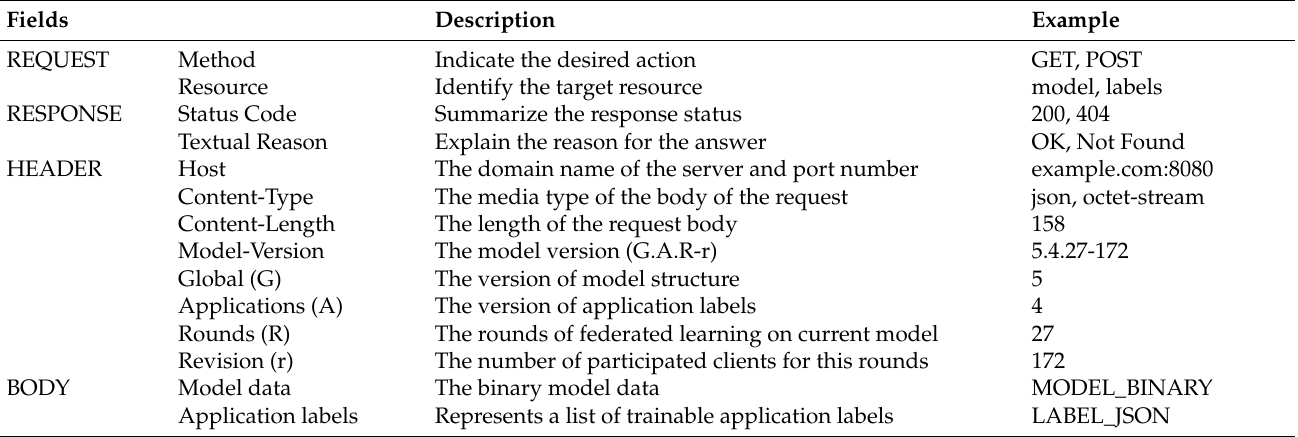
Table 1. FLIC protocol